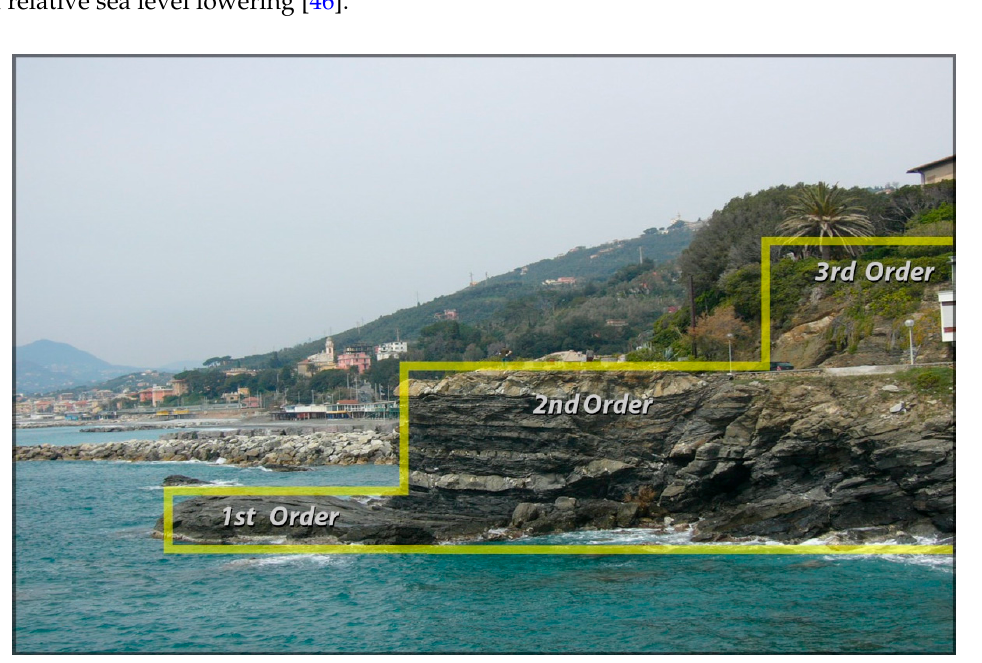
Figure 4. Staircase formed by different shore platform orders ( i.e. , different elevation), Eastern Liguria ‐ Villa Baldini locality.